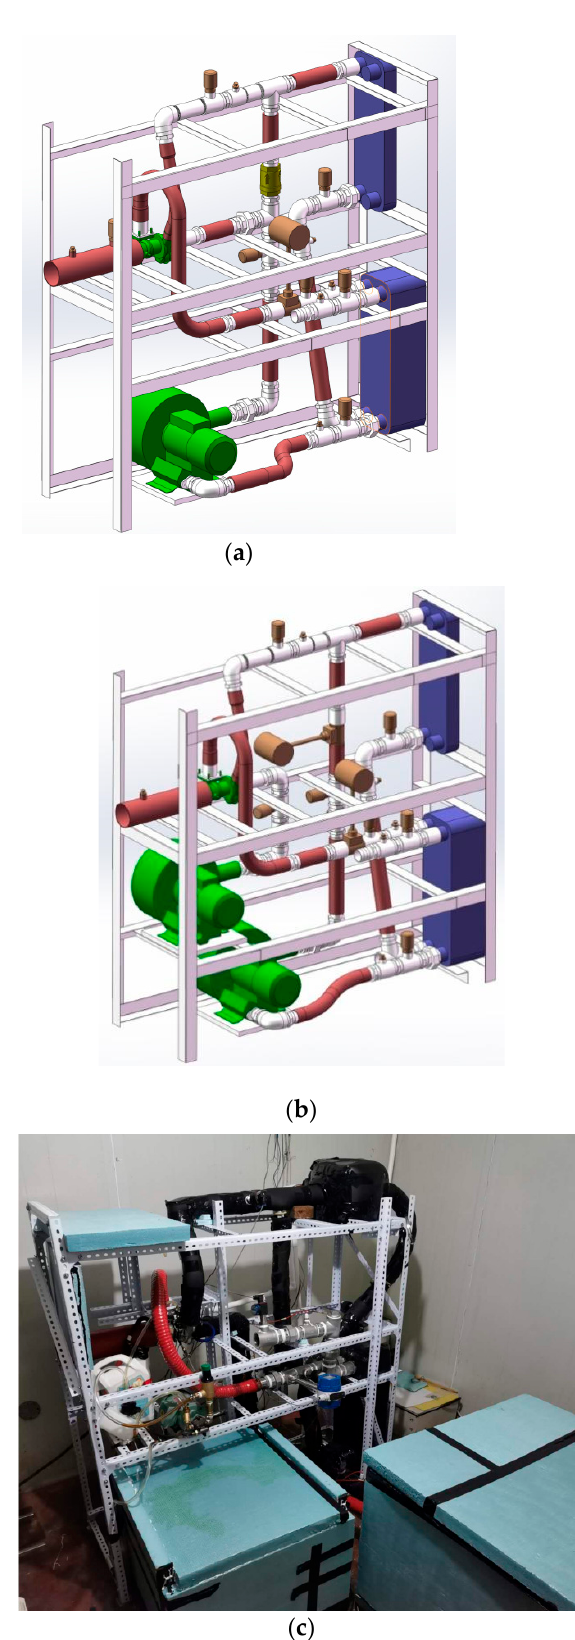
Figure 5. Diagrams of the test bench of the air-reversed Brayton heat pump with a turbocharger. ( a ) One-blower system. ( b ) Two-blower system. ( c ) Photograph of the air cycle heat pump system.